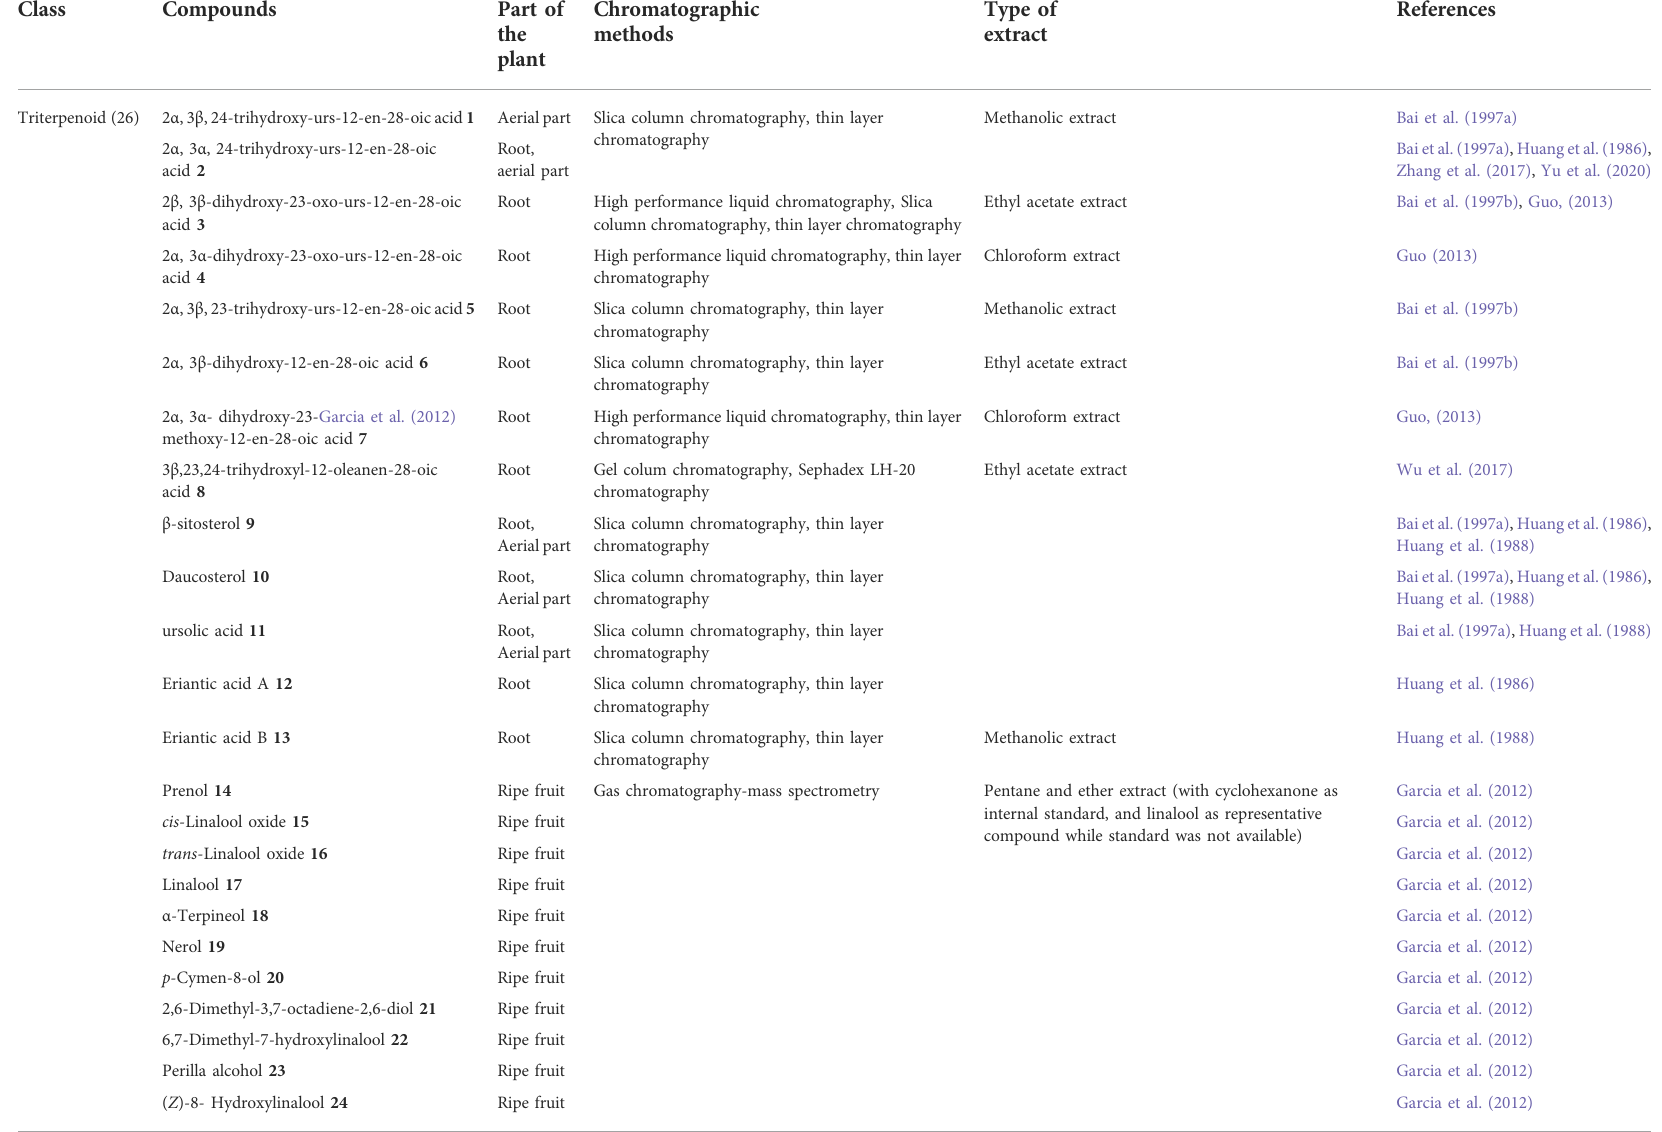
TABLE 1 The chemical constituents isolated from Actinidia eriantha